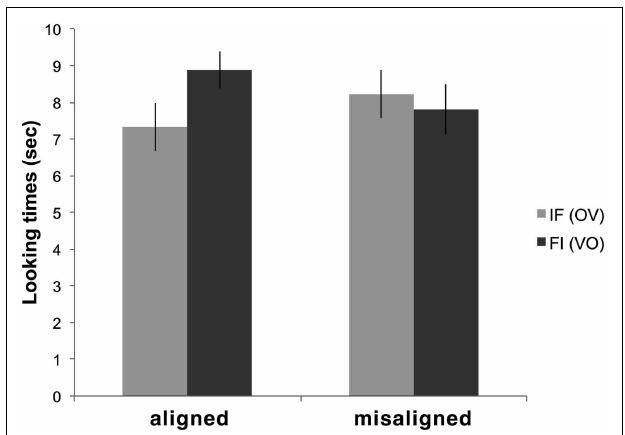
FIGURE 2 |The average looking times for FI and IF items in Conditions 1 and 2.